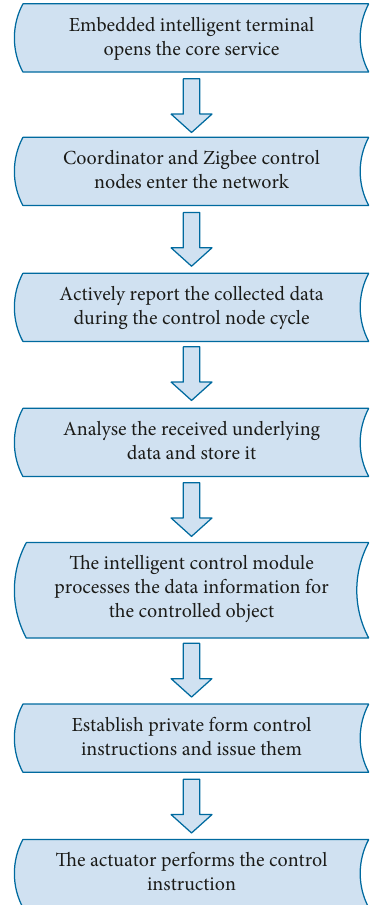
Figure 7: The control flow of the intelligent control